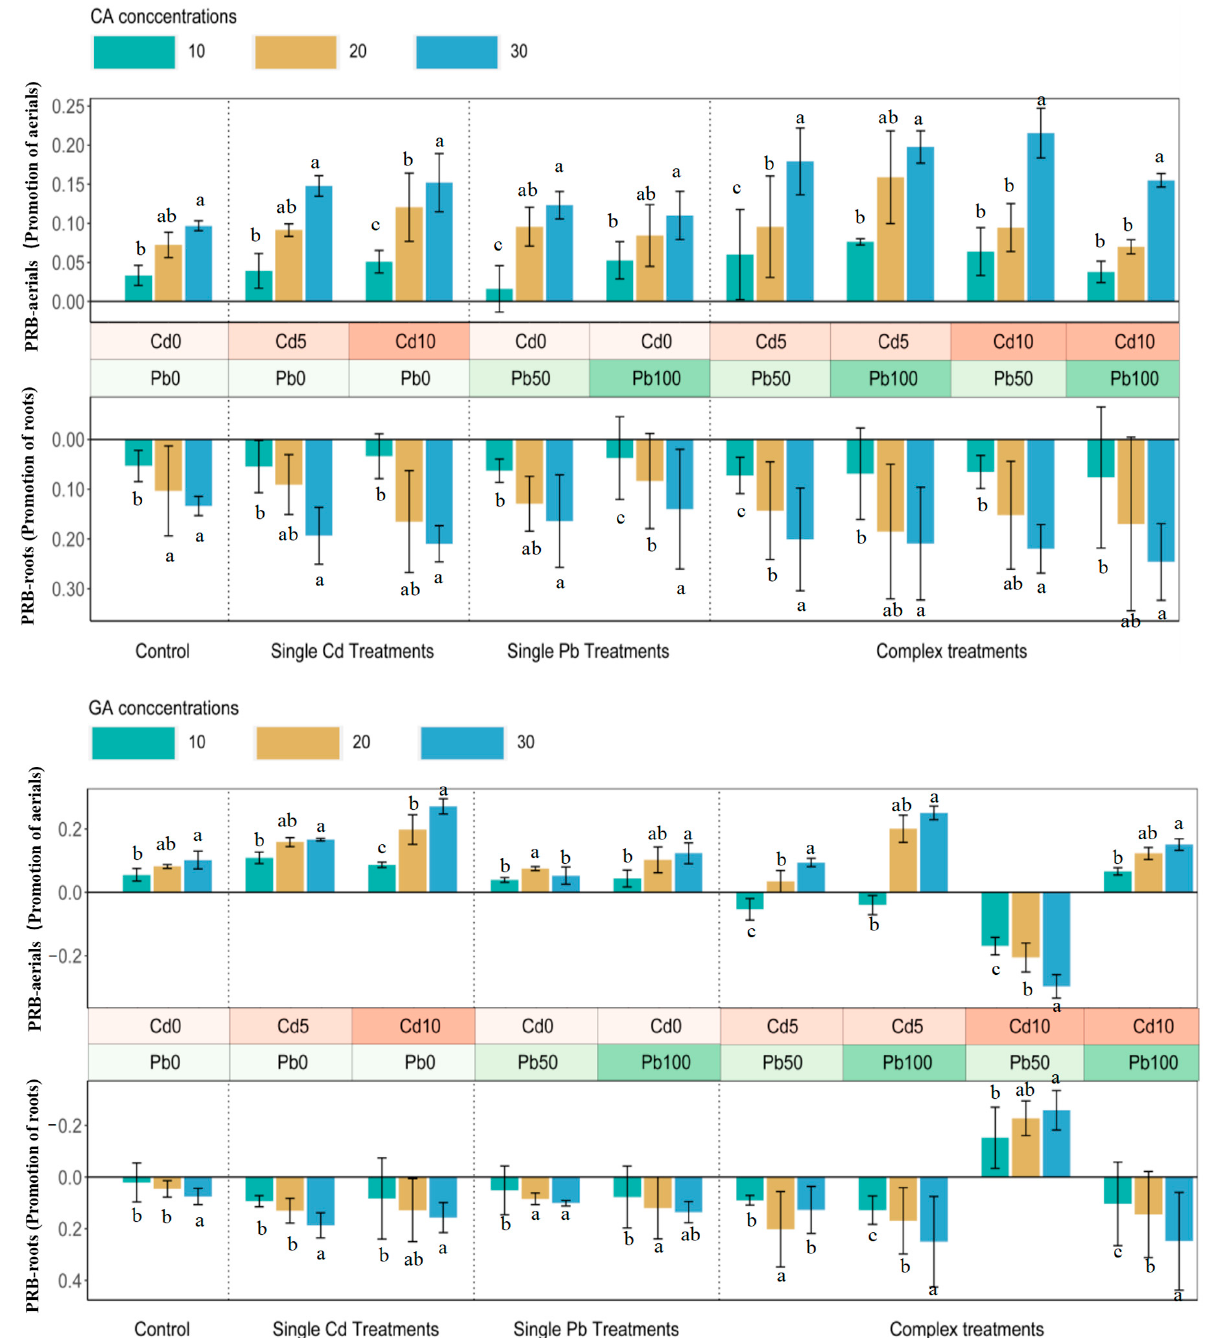
Figure 1. PRBs of aerials and roots of sunflower with citric acids and glutaric acids addition after 45 days. CA, citric acid; GA, glutaric acid; PRB, promotion ratio of biomass. Bars with different letters indicate significant difference at p < 0.05. Error bars represent ± S.E.